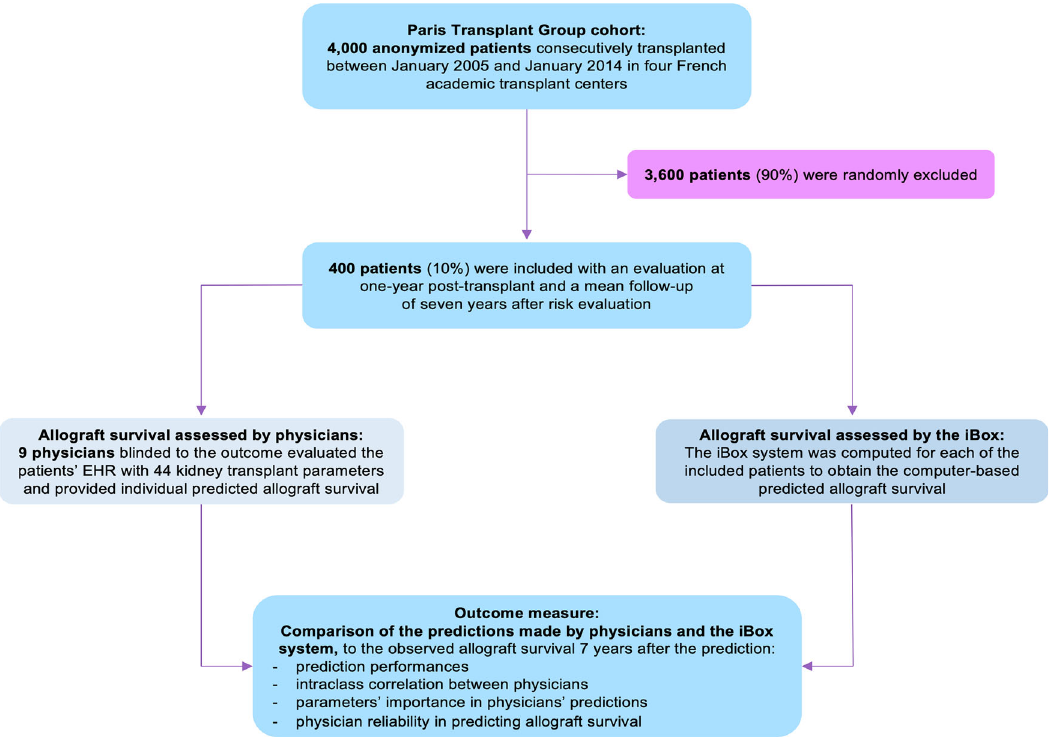
Fig. 1 Study Flowchart. Four hundred patients were randomly selected from the Paris Transplant Group database, a multicenter prospective cohort involving 4000 patients consecutively transplanted between 2005 and 2014 from four French academic transplant centers (Necker and Saint-Louis hospitals, Paris; Foch hospital, Suresnes; Toulouse hospital, Toulouse). Forty-four parameters from the fi rst year of transplantation were included and integrated into an anonymized Electronic Health Record (EHR) for evaluation by nine transplant physicians and the iBox prediction system. Allograft survival at seven years post-evaluation predicted by the physicians and the iBox were compared to the observed allograft survival to assess prediction performances. The agreement of physicians ’ predictions was compared using intraclass correlation, and the most important parameters in physicians ’ prediction were ranked and compared using mean decreased accuracy from a random forest algorithm and Fleiss kappa. EHR: electronic health